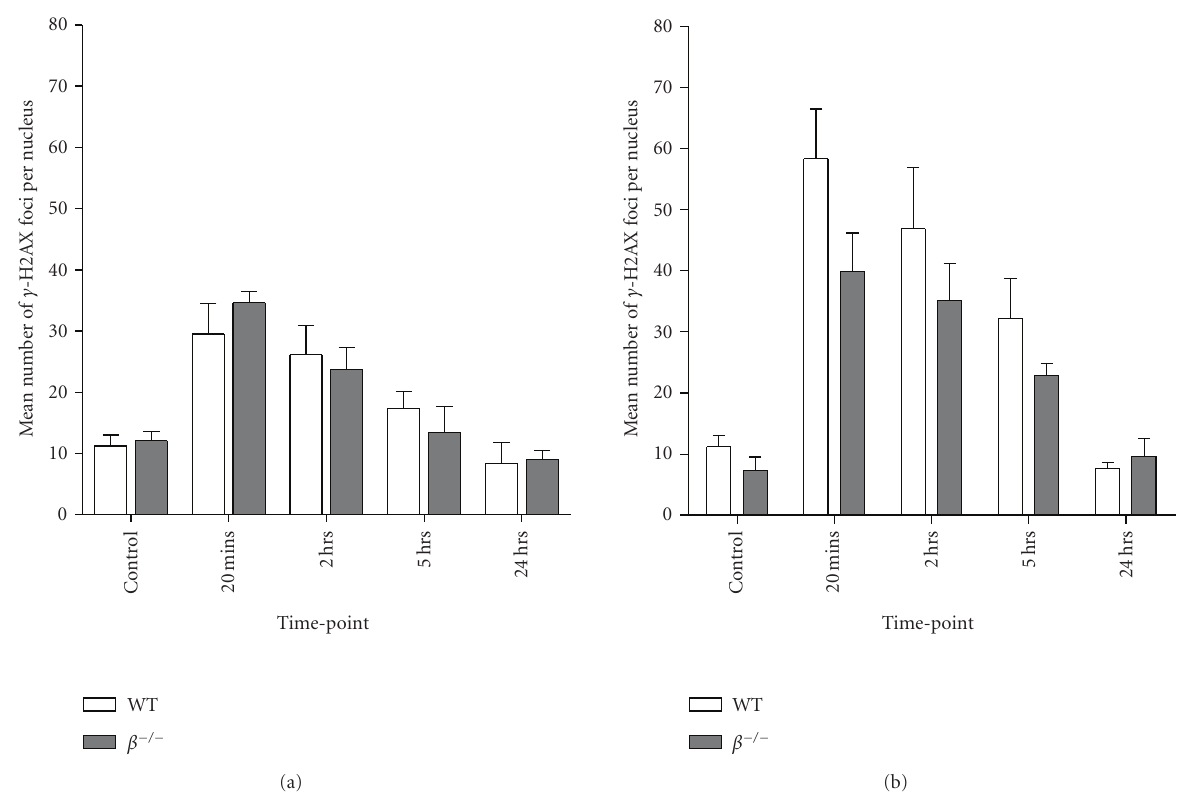
Figure 1: E ff ect of topoisomerase II β status on γ H2AX focus formation in response to IR. WT and TOP2 β − / − MEFs were exposed to 1Gy IR (a) or 2 Gy IR (b) and γ H2AX foci were counted at 20 minutes, 2 hours, 5 hours, and 24 hours after exposure. Data are derived from at least n = 3 independent